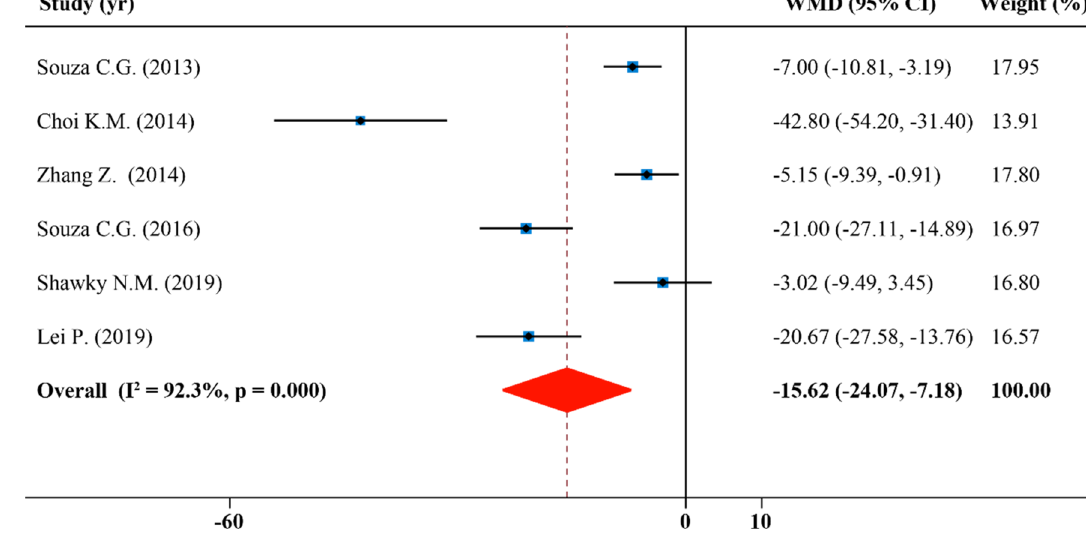
Figure 4. Forest plot showing effects of SFN on serum total cholesterol.